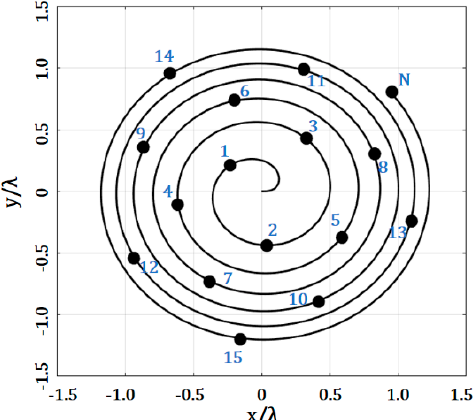
Figure 1. Antenna array, with elements distributed in the geometry of the Fermat spiral .